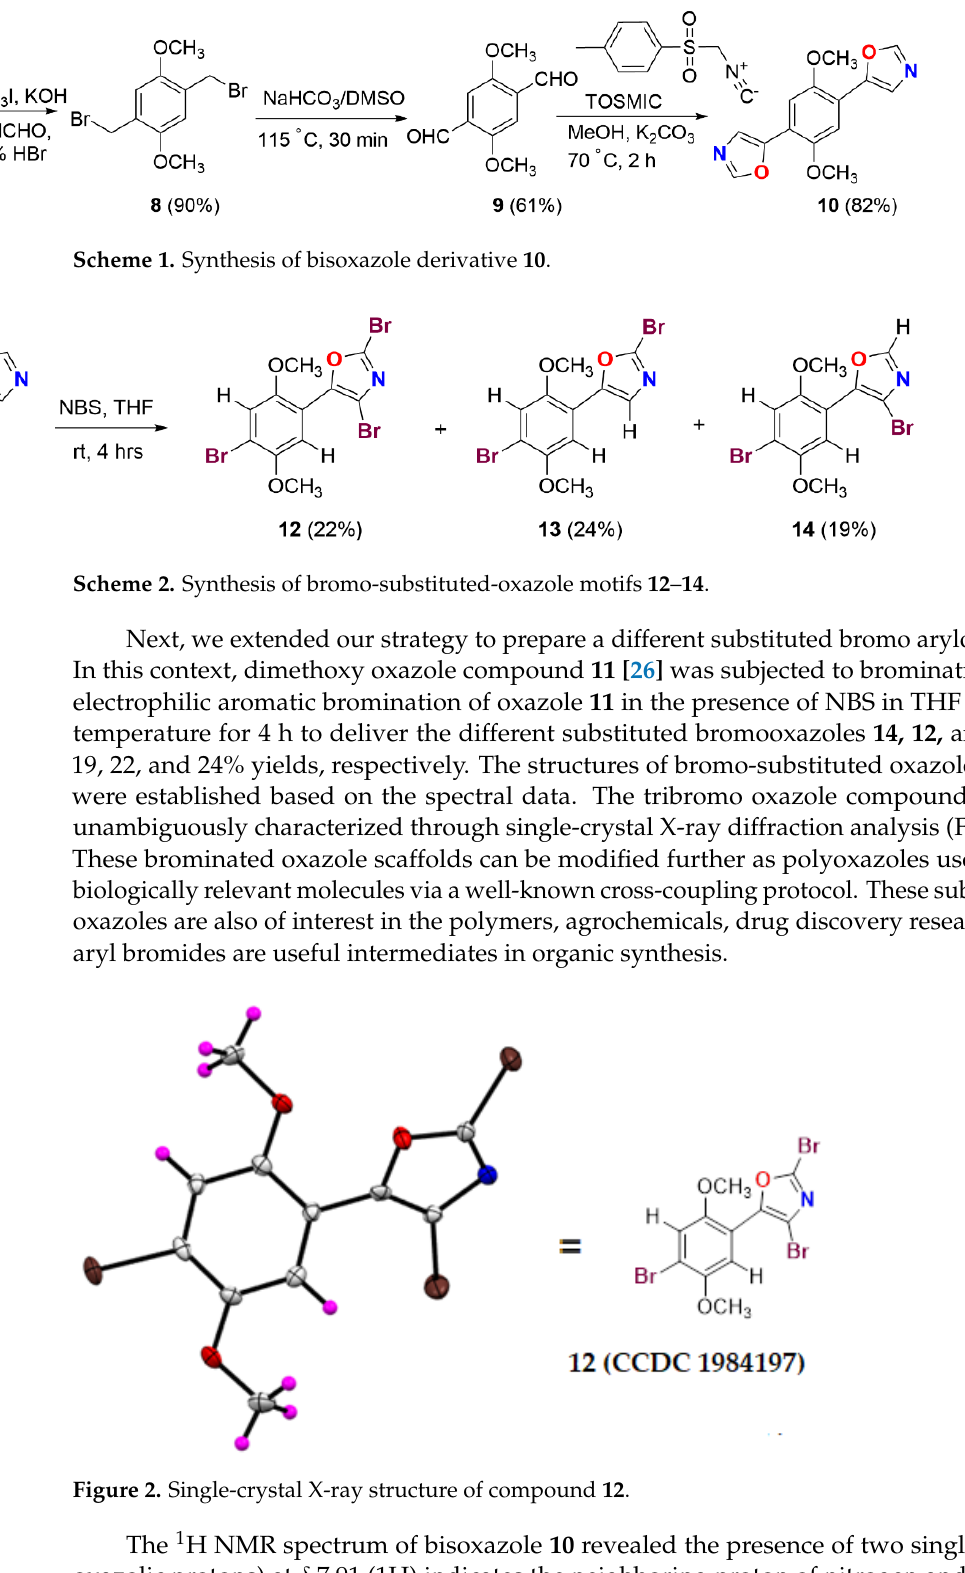
Figure 3. Correlation of 1 H and 13 C NMR value (s) of different oxazole frameworks. 3. Materials and Methods 3.1. General Information 2,5-Dimethoxybenzaldehyde, TosMIC, hydroquinone, NBS, and other essential rea- gents, chemicals, and necessary solvents were used as received and directly obtained from commercial suppliers without any further purifications. Thin-layer chromatography (TLC) plates were made on 10 × 5 cm glass plates layered with commercial- grade Acme’s silica gel (GF-254) containing 13% CaSO 4 , which acts as a binder. Reaction progress was analyzed using a chromatographic technique (TLC analysis) with suitable solvent systems (EtOAc/Pet ether), and observation was performed using UV, iodine spray and immersion in KMnO 4 solution. Column purification was performed using 100 – 200 mesh silica gel in all cases with suitable solvent systems. The boiling range of petroleum ether used in col- umn purification was around 60 – 80 °C. All IR samples were recorded using DCM and chloroform as solvents on a Nicolet Impact-400 FTIR spectrometer. Nuclear magnetic res- onance (NMR) spectra ( 1 H, 13 C and DEPT 135) were recorded on 400 and 500 MHz spec- trometers (Bruker) with CDCl 3 solvent, and chemical shifts (δ ppm) were reported relative to internal standards, such as TMS. The J values (coupling constants) are given in Hz. Mass spectra (HRMS) were recorded under positive ion electrospray ionization (ESI, Q- TOF) mode. Compounds 8 [32], 9 [31], and 11 [26] were prepared according to the litera- ture, and the data were consistent with the reported values. 3.2. Synthesis and Characterization 3.2.1. 5,5 ′ -(2,5-Dimethoxy-1,4-phenylene)Bis(oxazole) ( 10 ) TosMIC (220 mg, 1.13 mmol, 1.1 equiv. for each formyl group) and K 2 CO 3 (568 mg, 4.11 mmol, 4 equiv for each formyl group) in MeOH (10 mL) were added to a stirred so- lution 2,5-dimethoxyterephthalaldehyde ( 9 ) [31] (100 mg, 0.51 mmol, 1.0 equiv.). Later,